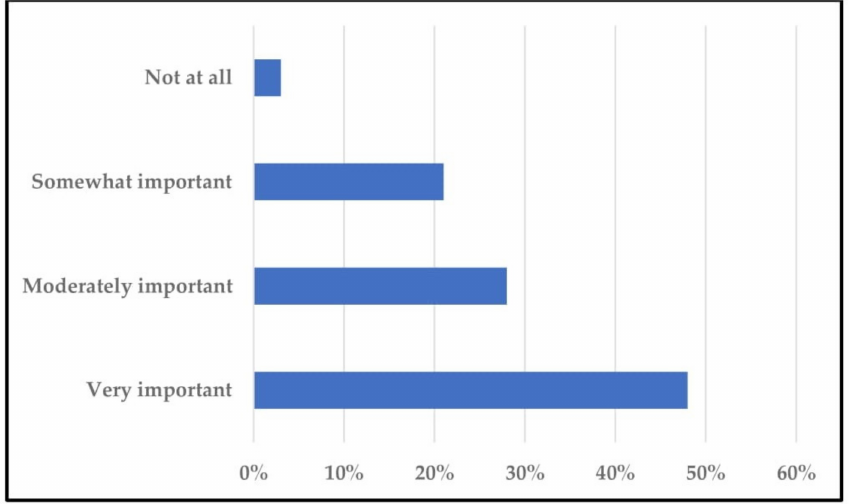
Figure 4. The importance of habitat connectivity to lifestyle block residents by percentage